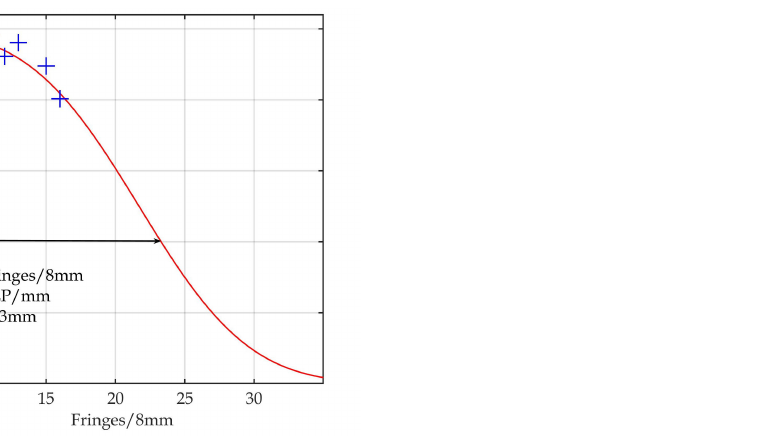
Figure 12. The “magnetic MTF” shows 2.9 Line pairs/8 mm (cid:118) ∆ y = 345 µ m, red line is fit with error function.